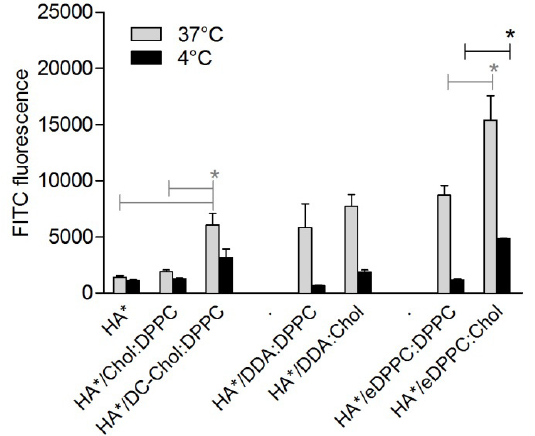
Figure 2. Effect of formulations on HA-FITC (indicated as HA*) uptake by DCs. Bars represent the mean fluorescence intensity (+SEM) of three batches of DCs incubated with HA-FITC alone or mixed with liposomes for 4 h at 37 °C versus 4 °C. Significant differences between the formulations are indicated with * ( p < 0.05). See Supplementary Material, Figure S1, for representative side scatter-forward scatter dot